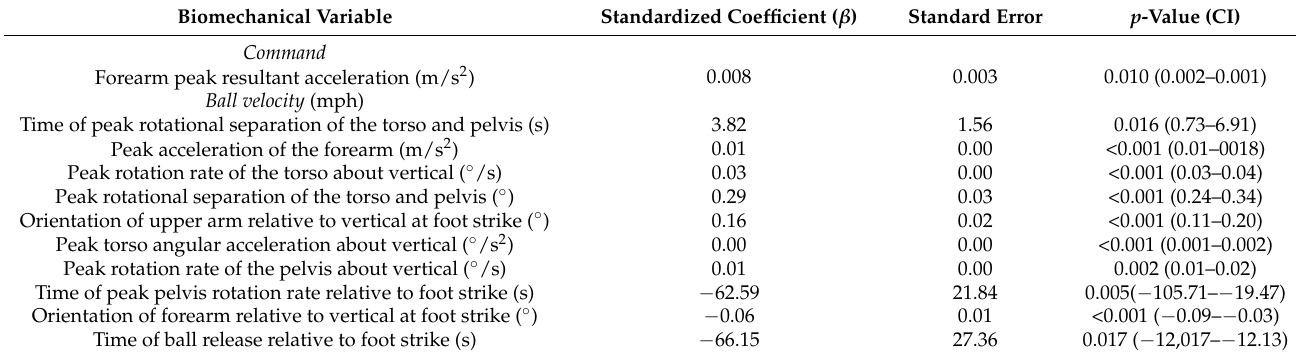
Table 2. Biomechanical variables remaining from stepwise regression model using backward elimina- tion. Variables are separated by pitch performance concept: command for all pitch types and ball speed for fastballs only.